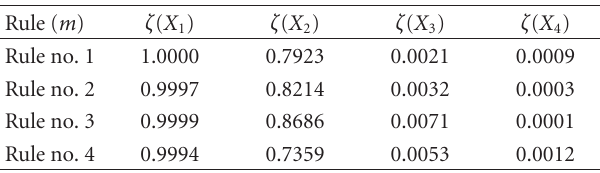
Table 4: Estimated fuzzy measures.